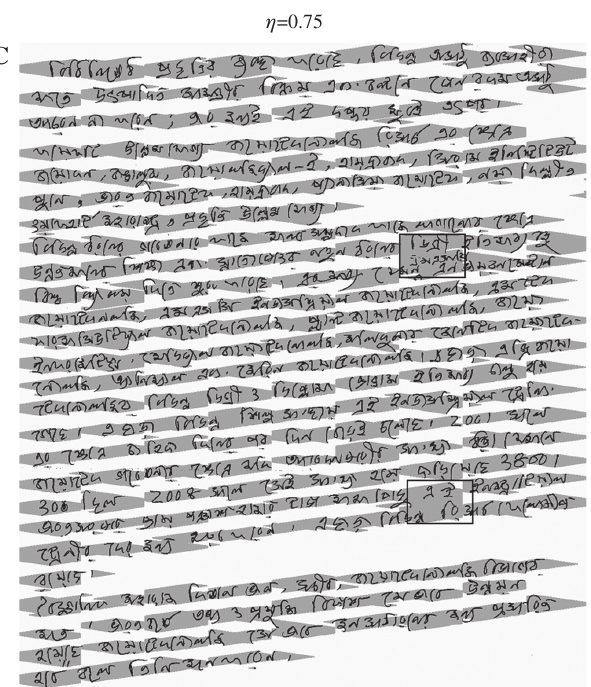
Figure 9. Variation in Output for Different Values of the Text Line Separation Parameter ( η ). It may be Observed that the Regions Marked in Rectangular Boxes are Better Separated with η =